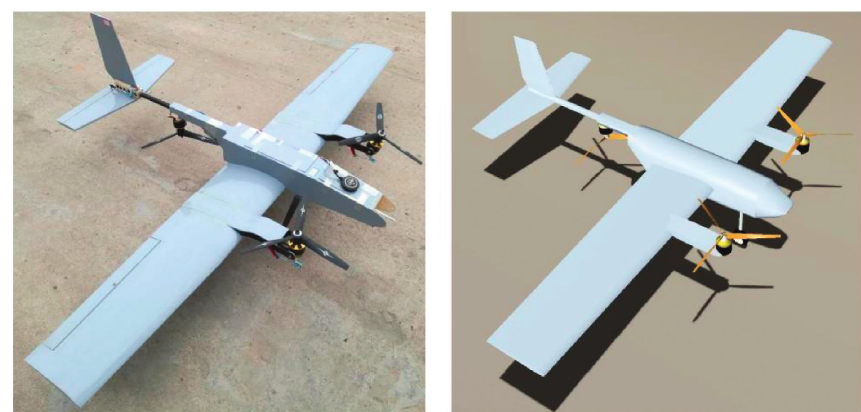
Figure 11: The prototype and X-plane model.